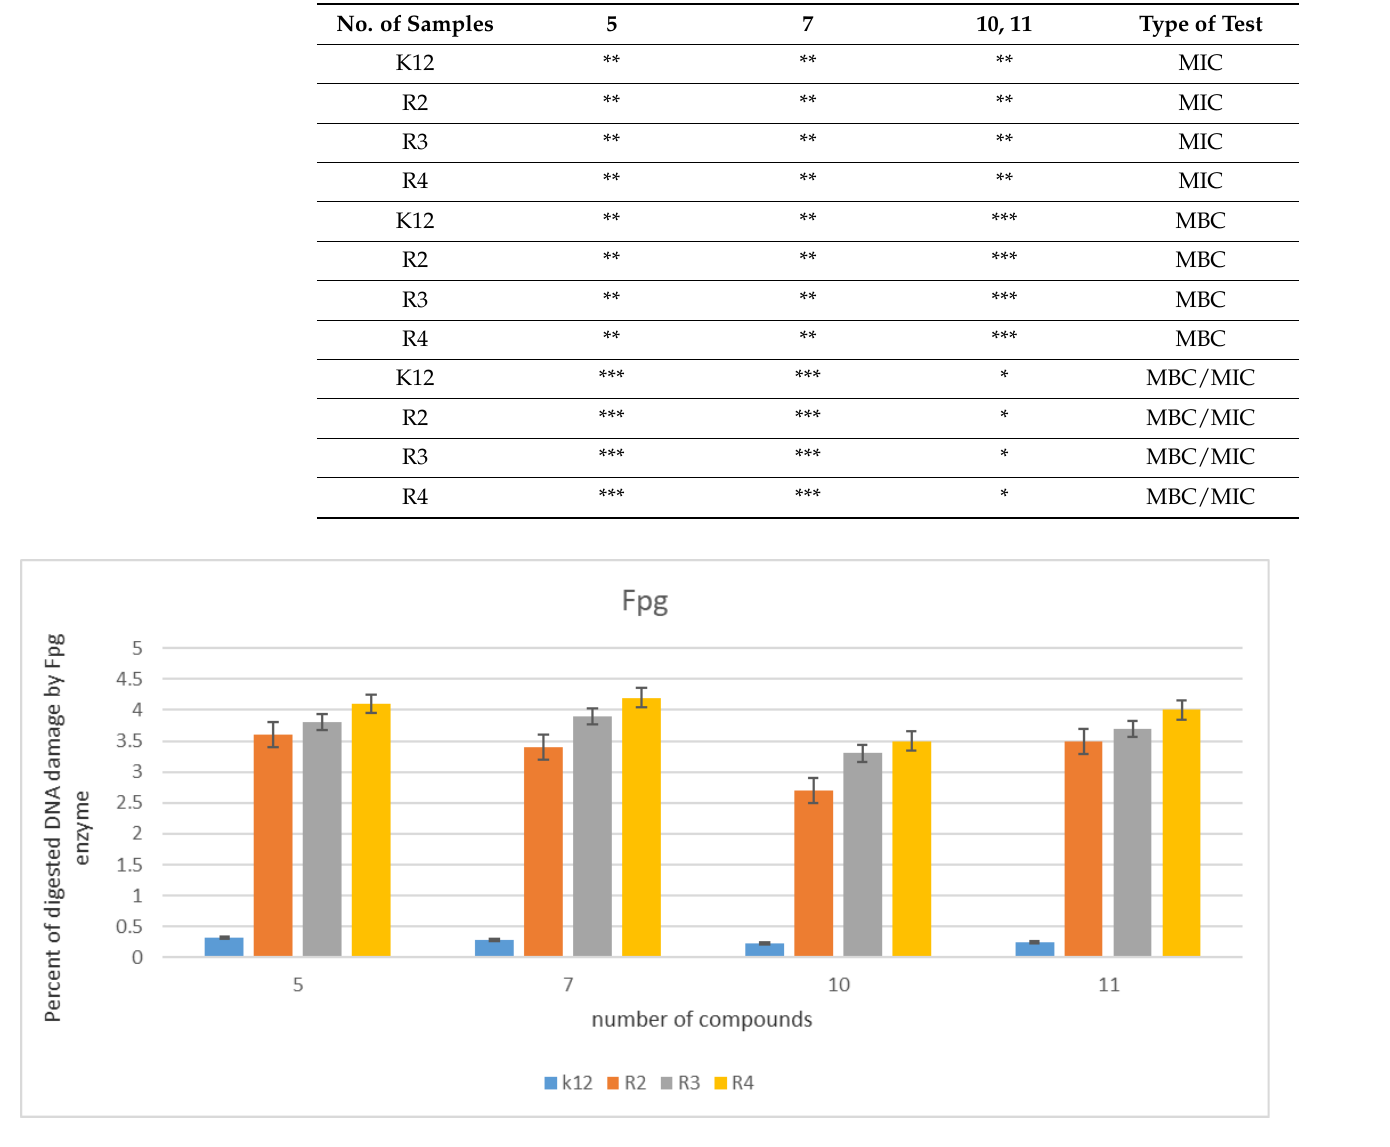
Figure 9. Percentage of plasmid DNA recognized by Fpg enzyme ( y -axis) with model bacterial, K12, and R2–R4 strains ( x -axis).